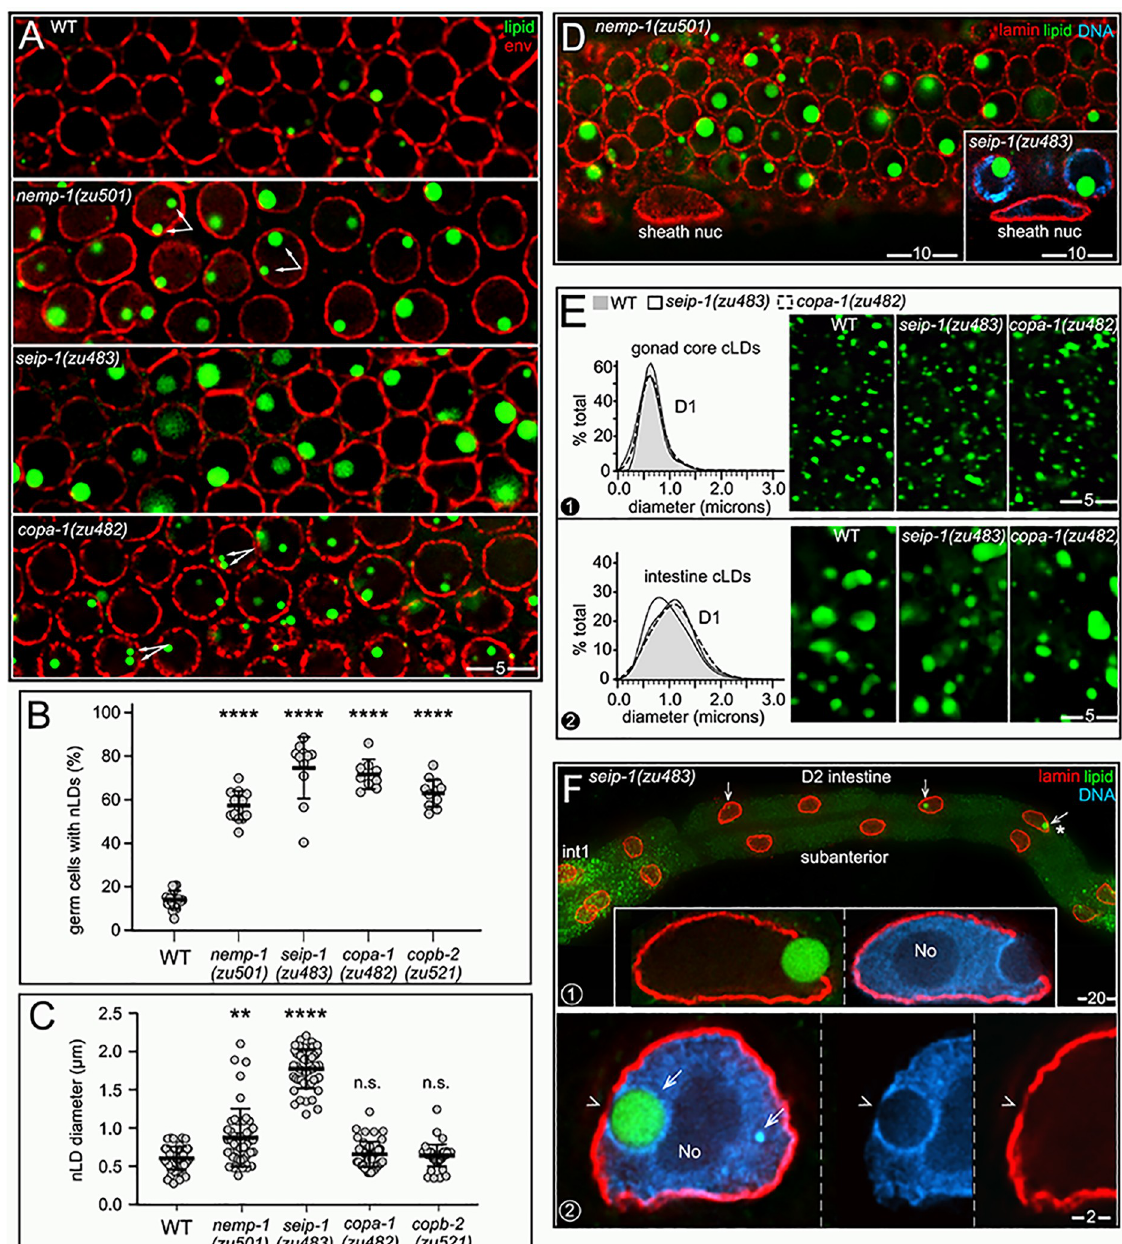
Fig 13. Mutants with abnormal nLD sizes or numbers. (A) Pachytene germ nuclei in wild-type and mutant gonads as indicated, showing lipid (green, BODIPY) and the nuclear envelope (red, NPP-9/RanBP2). The area shown corresponds to the peak nLD region in wild-type gonads (Fig 10H). Double arrows indicate multiple nLDs in single nuclei. Many of the mutant nuclei that appear to lack nLDs on the focal plane shown instead have nLDs visible on other focal planes. (B) Plot showing the percentage of germ cells with nLDs in the peak zone. (C) Plot comparing nLD diameters in the peak zone. (D) Images of the pachytene region of nemp-1(zu510) and seip-1(zu483) mutants, showing the absence of nLDs in gonad sheath nuclei. (E) Plot of cLDs sizes in the gonad core (panel 1) and intestine (panel 2; analyzed in the int2 cell group). The following numbers of cLDs were scored. (gonad core, intestine) = WT (4572, 5269); seip-1(zu483) (3316, 3379); copa-1(zu482) (2084, 3783). Curves were fitted using the Fit Spline/Lowess method to a plotted histogram with a bin size of 0.3 μ m. (F) Panel 1 shows a D2 seip-1(zu483) intestine stained for lamin (red, LMN-1), lipid (green, BODIPY), and DNA (blue, DAPI). Note the relative lack of cLDs in the subanterior region, similar to D2 wild-type intestines. This is an atypical intestine where three nuclei have nLDs (arrows), including one ruptured nucleus (inset). Panel 2 shows a large nLD coated with heterochromatin but not lamin. Note that the nLD is adjacent to a lamin- deficient region of the envelope (arrowhead), as observed for a some wild-type nuclei with large nLDs. Graphing was done in PRISM; p- values were calculated using the Welch’s t-test. ���� P < 0.0001, �� P < 0.01, n.s. not significant. Scale bars in microns as indicated.